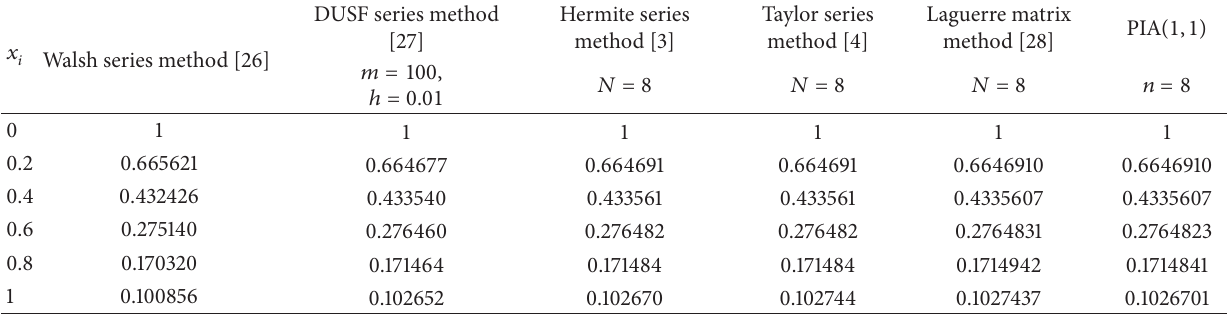
Table 3: Comparison of the PIA (1, 1) solution with other numerical methods for example 2 .